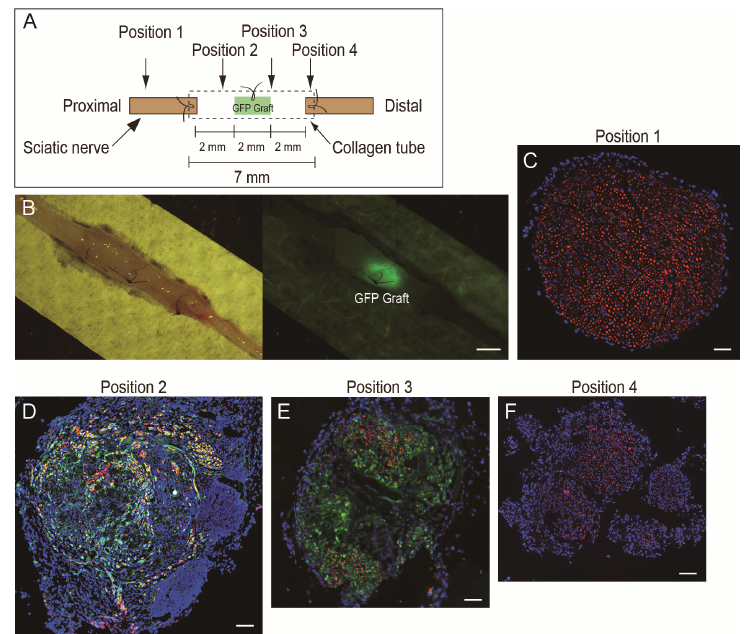
Figure 1. Schematic drawing of the nerve regeneration assessment model ( A ) and typical features of the regenerated bridging nerve ( B – F ). In ( A ), the GFP graft was a piece of sciatic nerve (2 mm) obtained from GFP ‐ Tg mouse. The 6 mm nerve gap was made using a 7 mm collagen conduit. ( B ) Typical macroscopic view of regenerated nerve. GFP nerve graft could be seen at the center of the tube conduit under fluorescence stereomicroscopy. Scale bar = 1 mm. ( C – F ): Typical cross ‐ sectional view of the regenerated nerve of the NT group at position 1–4. Sections were stained with N200 (red) as axon staining and nuclear staining with DAPI (blue). Scale bars = 100 μ m. GFP ‐ Tg, green fluorescent protein transgenic mice; DAPI, 4 ′ ,6 ‐ diamidino ‐ 2 ‐ phenylindole; NT, non ‐ cytokine administered control group.